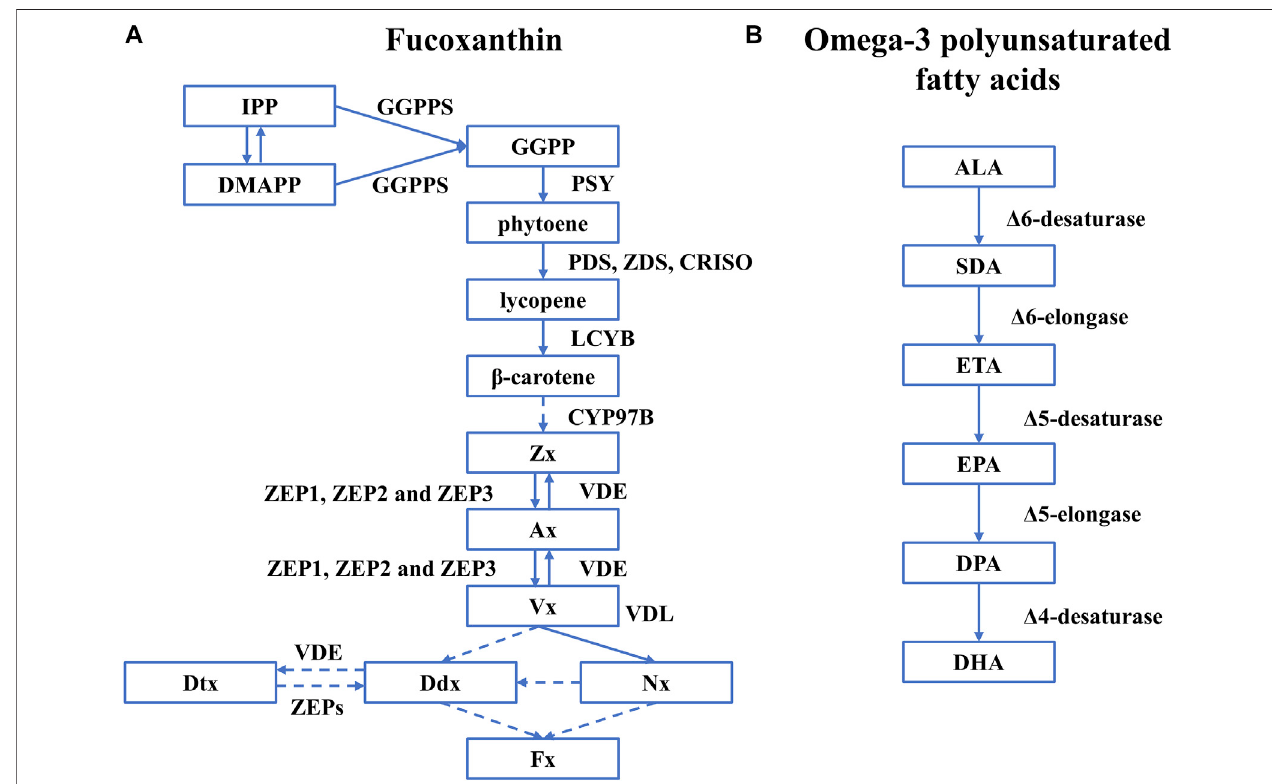
FIGURE 2 | The biosynthetic pathway of Fx and omega-3 polyunsaturated fatty acids in diatoms. Rectangles represent intermediates, and arrows represent biosynthetic pathways and active enzymes. (A) Fucoxanthin. The fi gure was adapted from a previous publication (Manfellotto et al., 2020). A dashed line represents the unknownbiosyntheticprocess. (B) omega-3polyunsaturatedfattyacids.The fi gurewasadaptedfromapreviouspublication(Sayanovaetal.,2017)andonlycoversthe pathway of omega-3 polyunsaturated fatty acids. Abbreviations: IPP, isopentenyl pyrophosphate; DMAPP, dimethylallyl diphosphate; PSY, phytoene synthase; GGPPS, geranylgeranyl pyrophosphate synthase; GGPP, geranylgeranyl diphosphate; PDS, phytoene desaturase; ZDS, ζ -carotene desaturase; CRISO, carotenoid isomerase; LCYB, lycopene β -cyclase; Zx, zeaxanthin; ZEP1, ZEP2, and ZEP3, three types of Zea epoxidase; VDE, violaxanthin de-epoxidase; Vx, violaxanthin; VDL, violaxanthin de-epoxidase-like proteins; Nx, neoxanthin; Ddx, diadinoxanthin; Dtx,